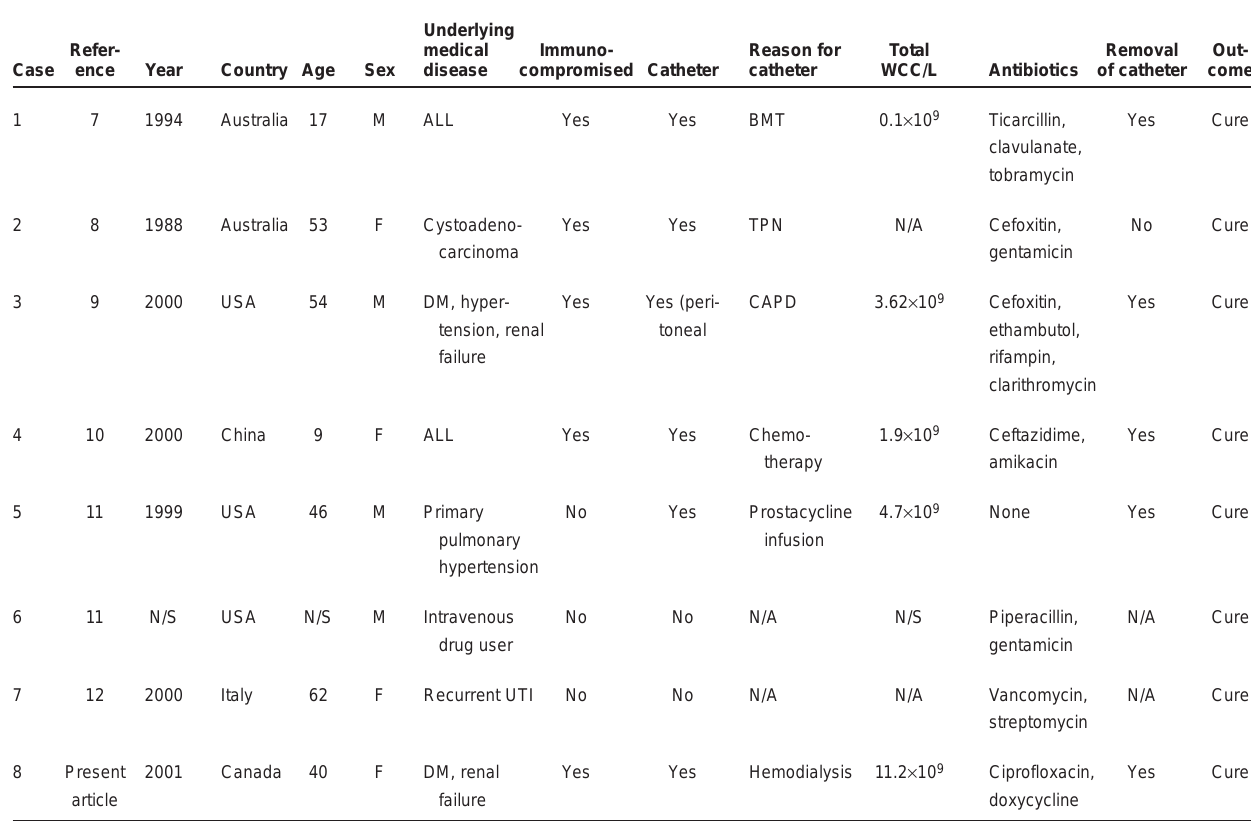
TABLE 1 Characteristics of Mycobacterium neoaurum infections